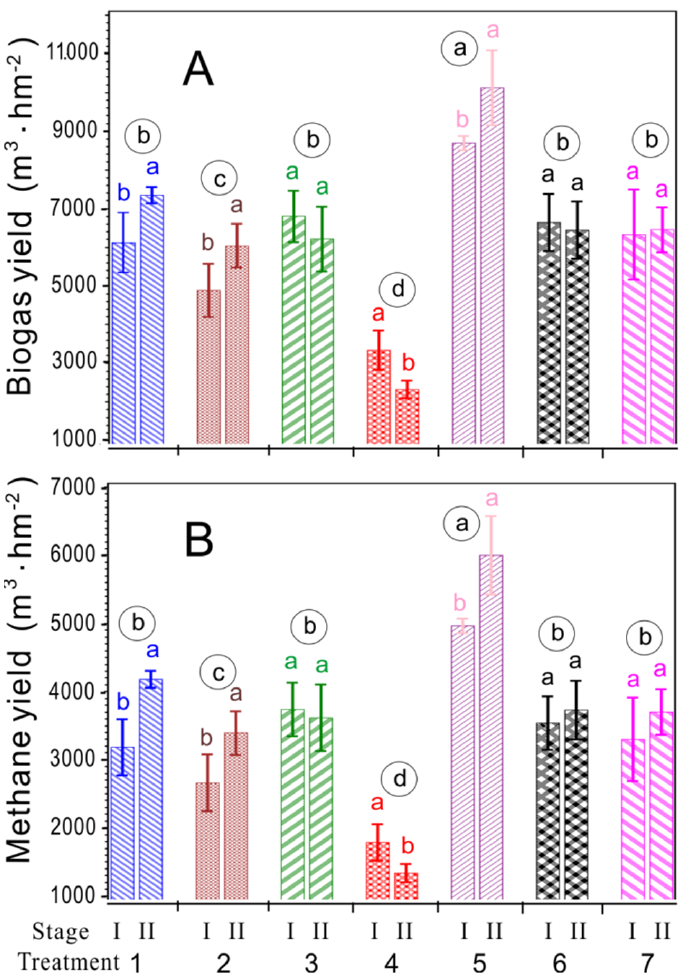
Figure 2. Yields of biogas ( A ) and methane ( B ). The different lower letters in the circle indicate the difference among the treatments; the different color lower letters indicated the difference between harvested stages I and II in their treatment. n = 8. Treatments include, 1: pure oat; 2: 50% winter pea:50% oat; 3: 75% winter pea:25% oat; 4: pure winter pea; 5: pure triticale; 6: 50% winter pea:50% triticale; 7: 75% winter pea:25% triticale. Stages include: 1. full-flowering stage of winter pea and beginning of milky stage of cereals and 2. emergence of firsts pods for pea and milky/waxy stage of